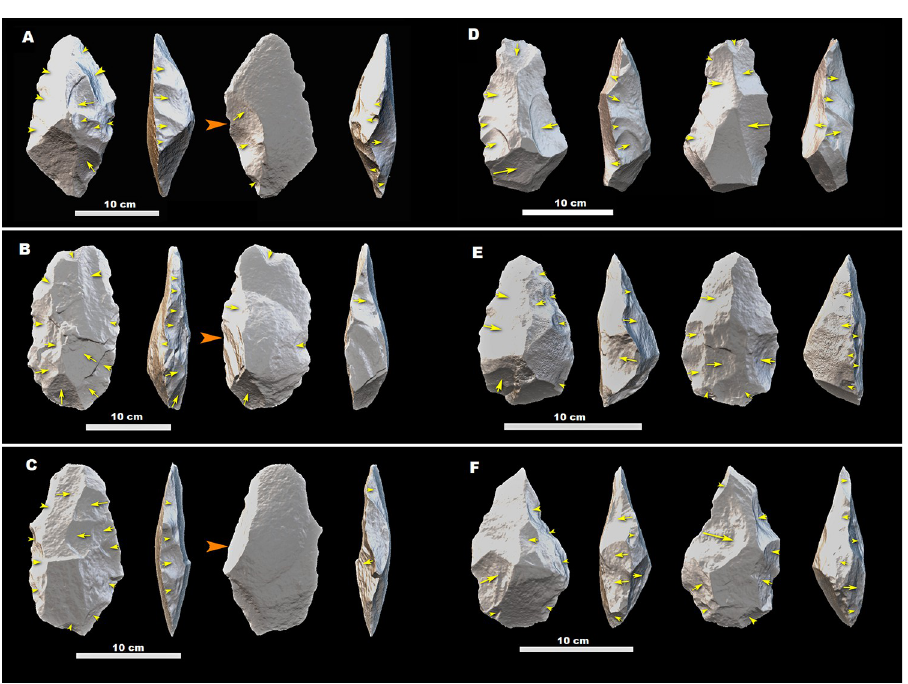
Fig 10. Handaxes from MW2-L1&L2. (A), (B), and (C) are made on side-struck flake blanks (see the direction of the arrows), while the blanks of (D), (E), and (F) are indeterminate. All tools are made on glassy ignimbrite. Orange arrows indicate the direction of flaking of the blanks, while yellow arrows indicate the direction of removals during shaping phases.